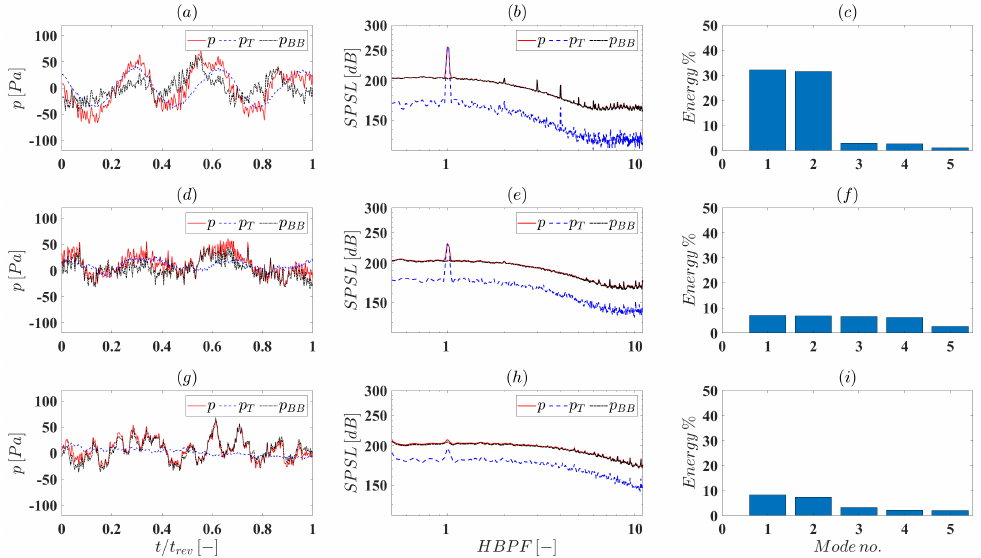
Figure 9. Application of the POD–based decomposition strategy to the test cases under analysis. ( a ) Time history of the raw pressure signal and of its tonal and broadband components for the propulsive regime. ( b ) Nondimensional spectra for the propulsive regime. ( c ) Energy percentage associated with the POD modes for the propulsive regime. ( d ) Time history of the raw pressure signal and of its tonal and broadband components for the transition regime. ( e ) Nondimensional spectra for the transitional regime. ( f ) Energy percentage associated with the POD modes for the transitional regime. ( g ) Time history of the raw pressure signal and of its tonal and broadband components for the regenerative configuration. ( h ) Nondimensional spectra for the regenerative configuration. ( i ) Energy percentage associated with the POD modes for the regenerative regime.